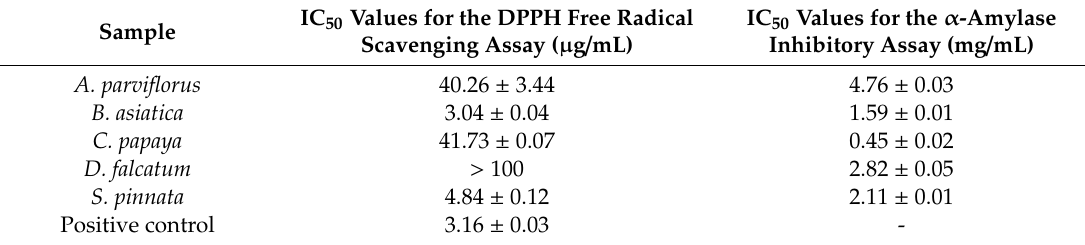
Table 4. The IC 50 values a for the DPPH free radical scavenging and α -amylase inhibitory activities of the